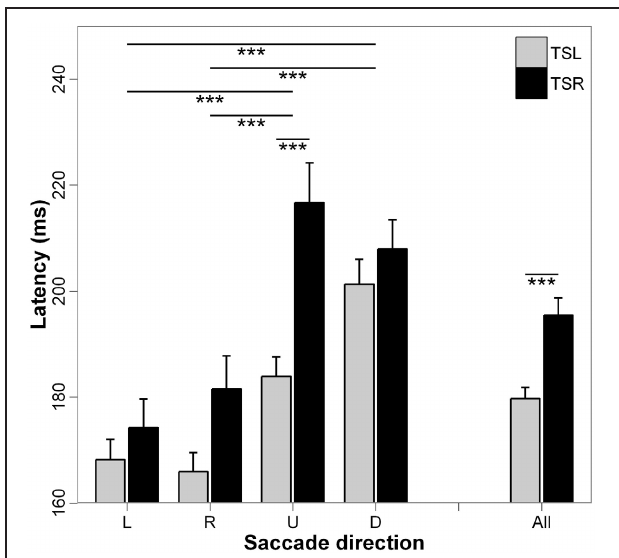
FIGURE 2 | Mean values of latency for each saccade direction (L, leftward; R, rightward; U, upward; D, downward) and tinnitus side (TSL, tinnitus side left; TSR, tinnitus side right). Error bars represent the standard error. The symbol * indicates a statistically significant effect ( ∗ p < 0 . 05; ∗∗ p < 0 . 01; ∗∗∗ p < 0 . 001).